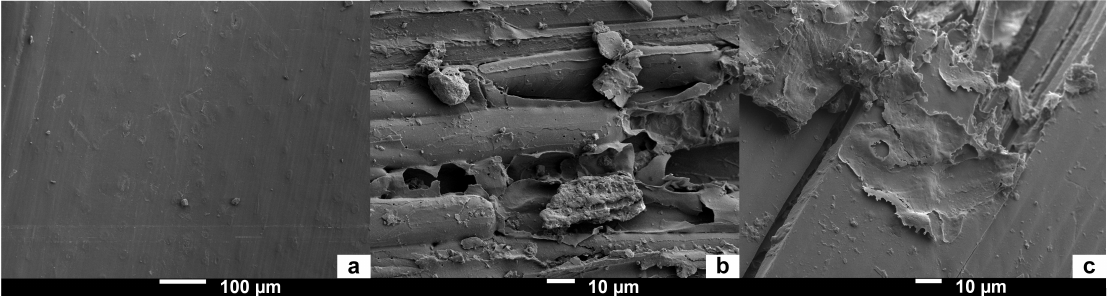
Figure 7. SEM micrographs of the wheat straw surface: ( a ) Without treatment; ( b , c ) After hydrothermal treatment